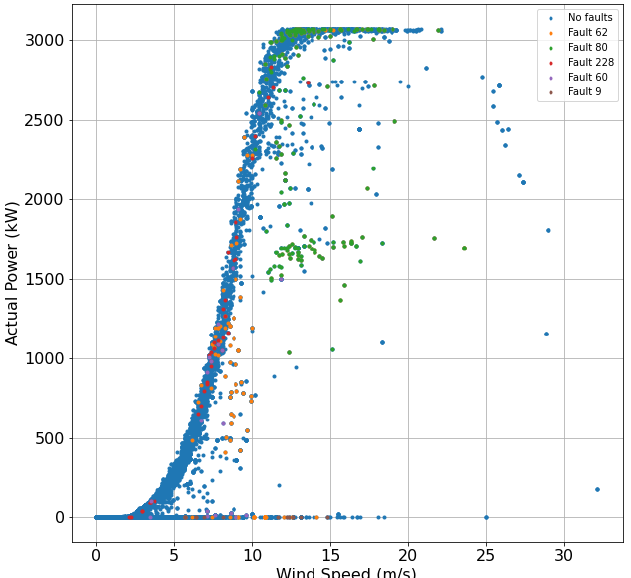
Figure 7. Power and wind speed with respect to non-faulty status and all individual